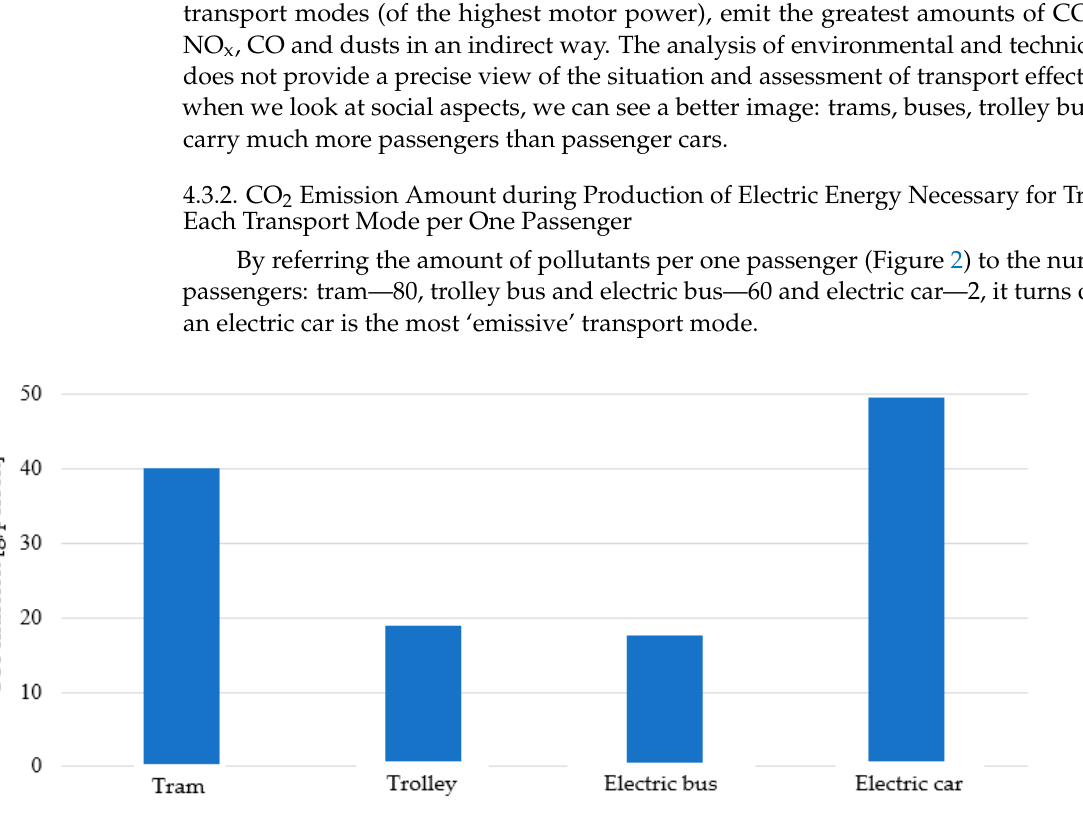
Table 8. The amount of emitted compounds during production of electric energy that are needed for each transport mode to cover a distance of 1 km.